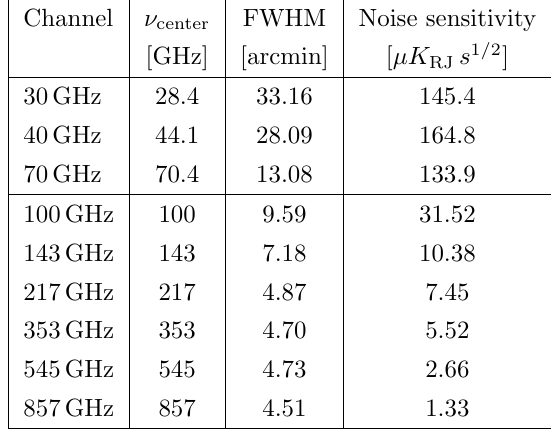
Table 1: Planck performance parameters determined from flight data (Planck Collaboration I